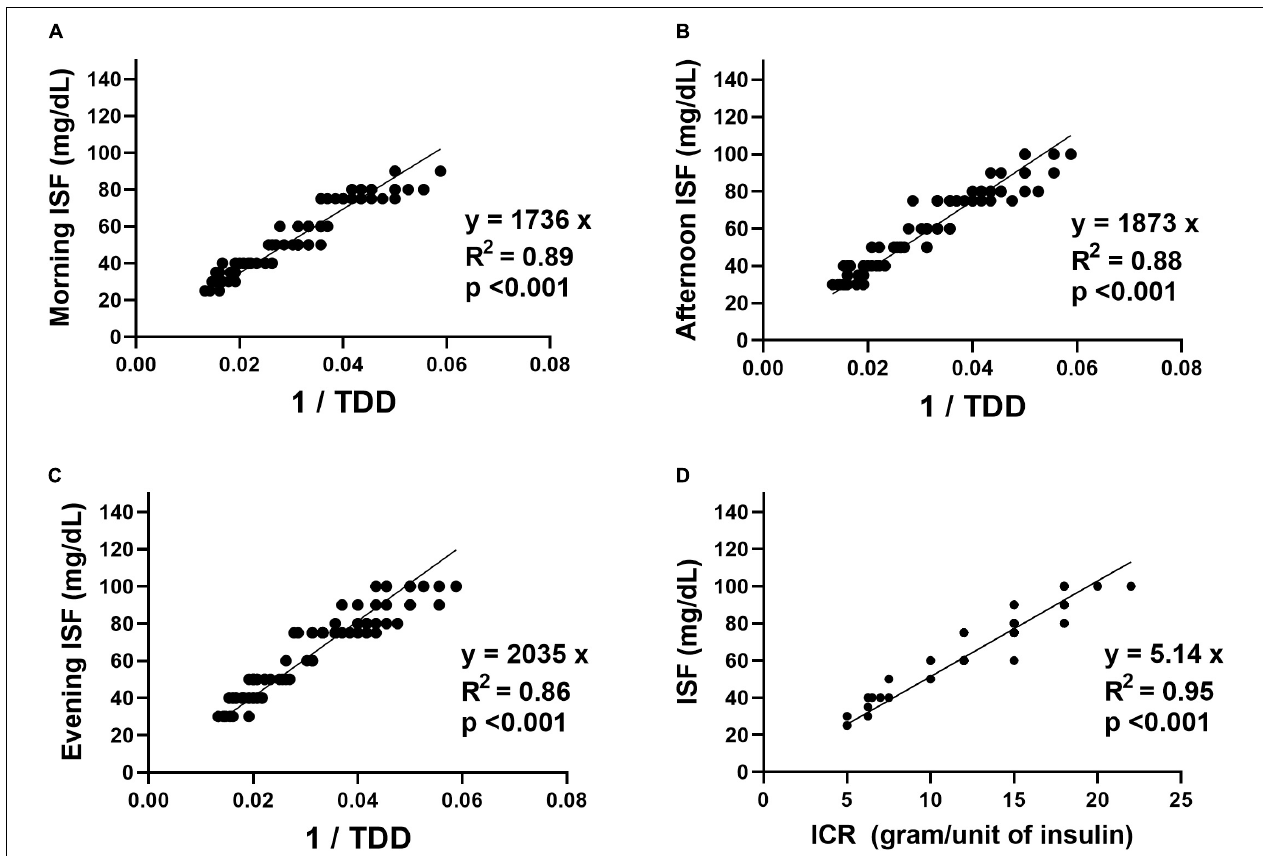
FIGURE 1 | The relationships between the insulin sensitivity factor (ISF) in mg/dL for the study participants and their insulin-to-carbohydrate ratio (ICR) in grams/unit of insulin and total daily insulin dose (TDD) in units/day. (A) The relationship between the morning ISF and the reciprocal of the TDD. (B) The relationship between the afternoon ISF and the reciprocal of the TDD. (C) The relationship between the evening ISF and the reciprocal of the TDD. (D) The relationship between the ISF for different times of the day and the ICR for the same time of the day.